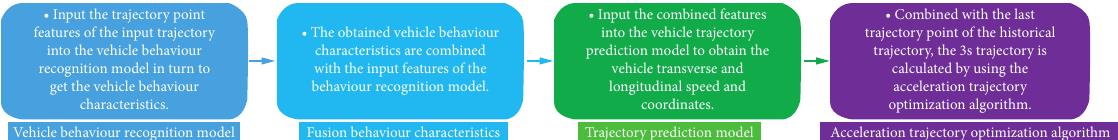
Figure 1: The basic flow of trajectory